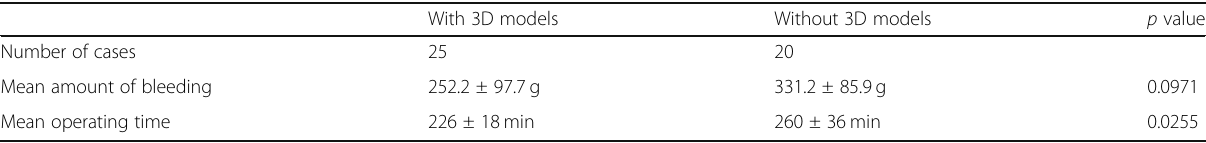
Table 2 Comparison of surgical outcomes with and without 3D models. Welch ’ s t test was used to test the difference between the mean values of amount of bleeding and the operating